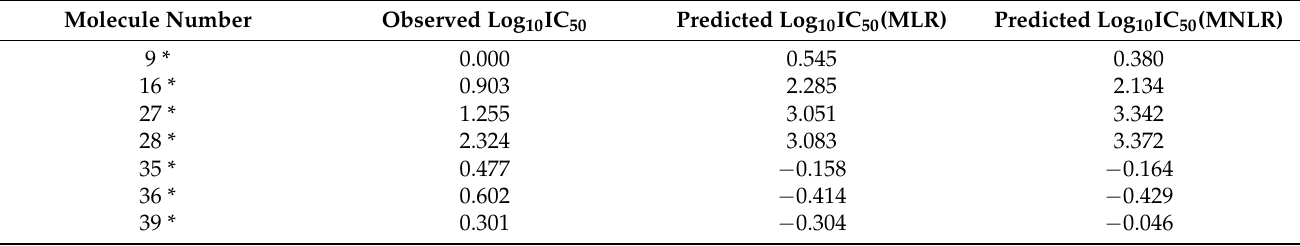
Table 4. External validation results of the MLR and MNLR models.